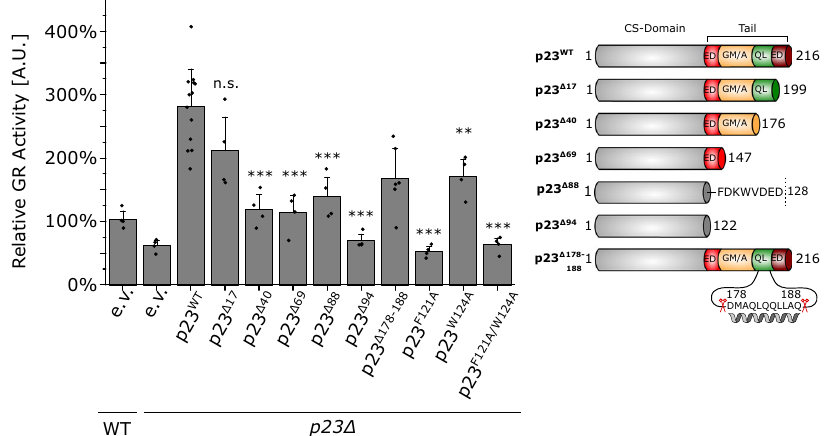
Fig. 6 The p23 tail is required for GR folding in vivo. Wild-type or sba1 Δ yeasts cells were examined concerning their ability to mature heterologously expressed glucocorticoid receptor (GR). Cells either harbored the empty vector (e.v.) plasmid as control or expressed the indicated p23 mutants. The relative GR activities compared to the wild-type control are shown. Bars represent means ± SD of at least four independent experiments. Signi fi cance was evaluated by two-tailed t-testing (n.s. P ≥ 0.05; * P ≤ 0.05; ** P ≤ 0.01; *** P ≤ 0.001) and Welch correction was used if variances were signi fi cantly different between samples. [p(p23 Δ 17 ) = 0.06, p(p23 Δ 40 ) = 0.00014, p(p23 Δ 69 ) = 0.00012, p(p23 Δ 88 ) = 0.00054, p(p23 Δ 94 ) = 9.6 × 10 − 9 , p(p23 Δ 178-188 )